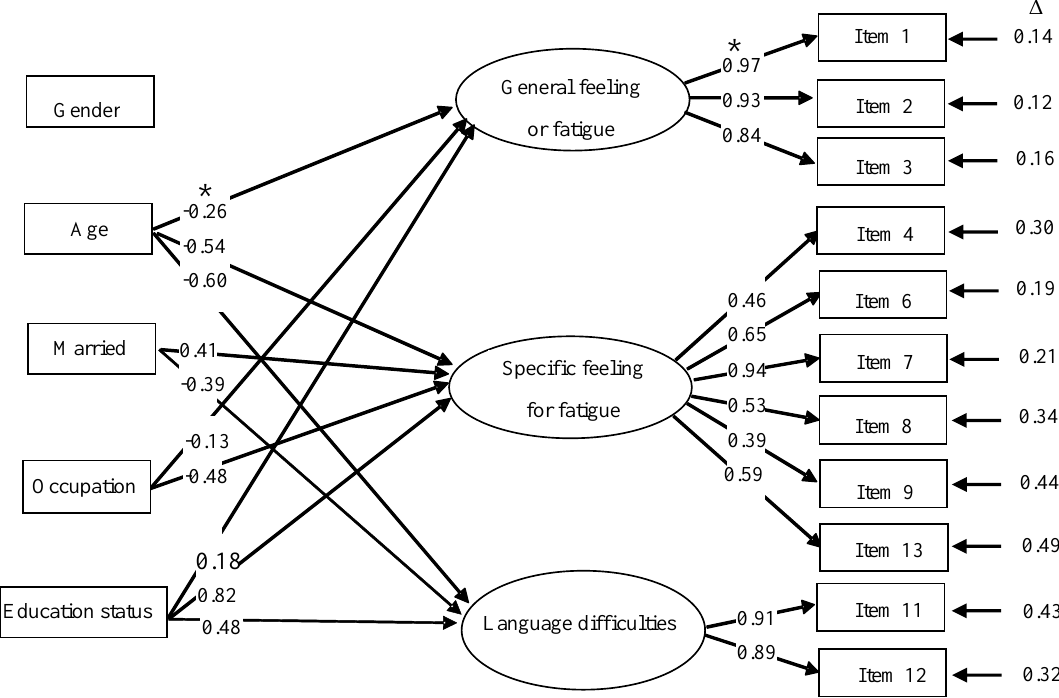
Figure 2. Associations between the CFS factors and covariates in the three-factor ESEM model of 11-item version. * Correlation coefficients; ∆ residual error.